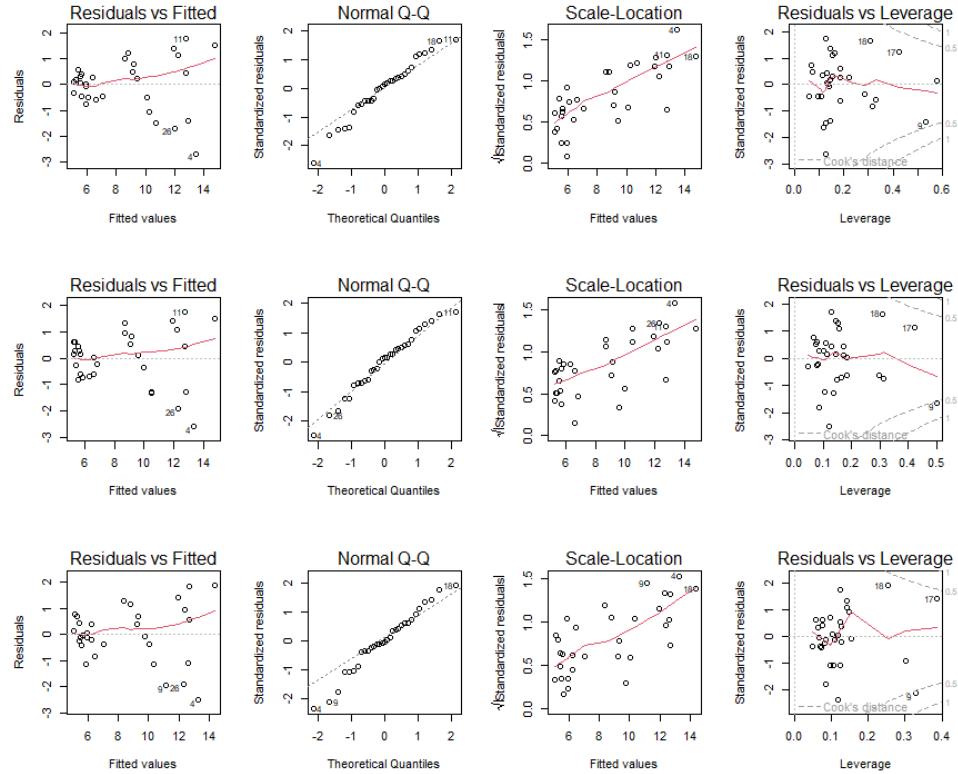
Figure A3. Goodness − of − fit of the seated row 1 − RM equation models.